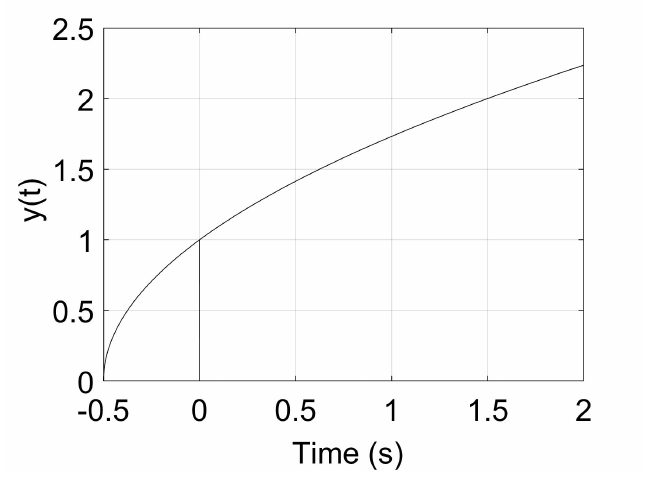
Figure 12. Circuits to generate the values of y(t) and y’(t) Figure 13. Circuits to generate the values of y(t) and y (cid:48) (t). If we turn around the Y axis, the solution from the corresponding circuit and call x to t , the Figure 14 is obtained.